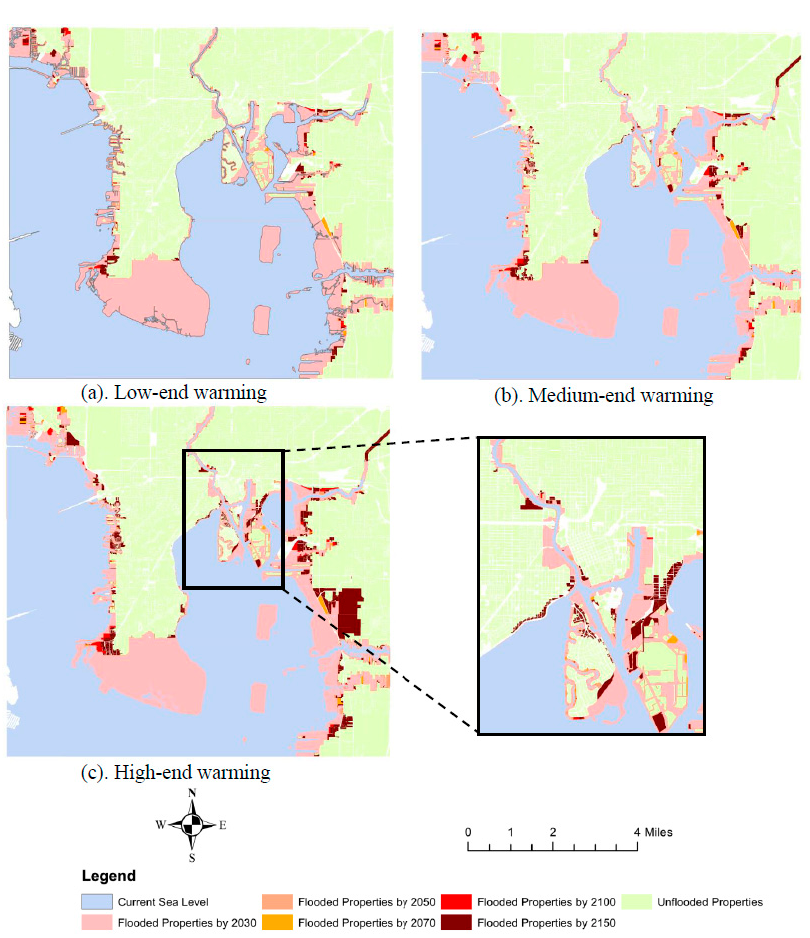
Figure 3. Flooded properties due to sea-level rise in Tampa: ( a ) low-end warming, ( b ) medium-end warming, and ( c ) high-end warming.